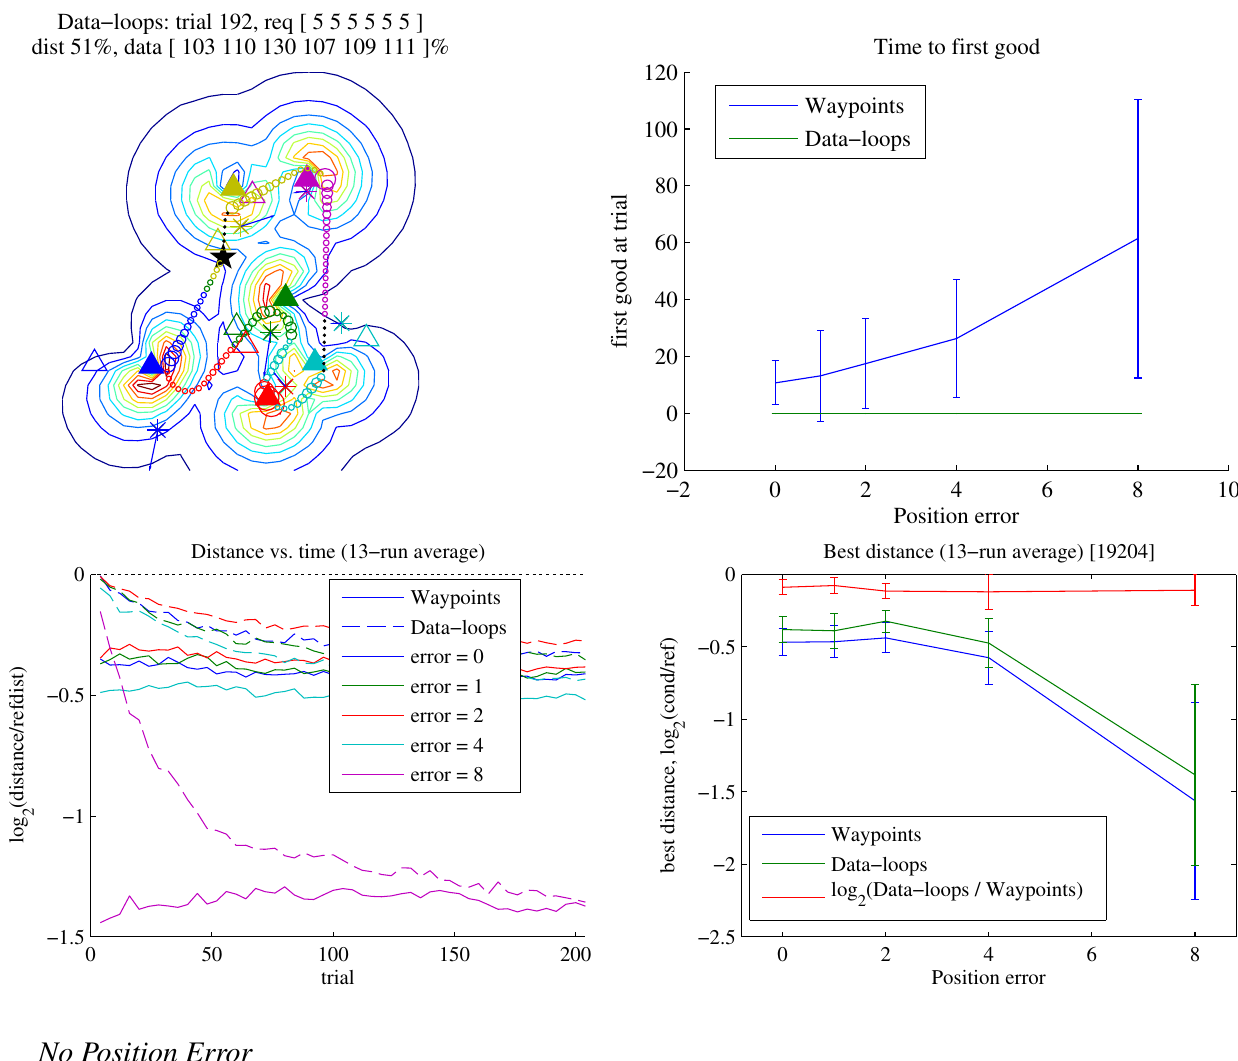
Figure 8. Trajectory quality through time as the error in node position information increases. Here we used 6 nodes, each with a requirement of 5. Each randomly generated field is 20 × 20 , nodes are placed uniformly randomly, and the orientations of their dipole antennas are randomly distributed. Position error is the radius of a circle on which nodes are placed uniformly randomly from the true node